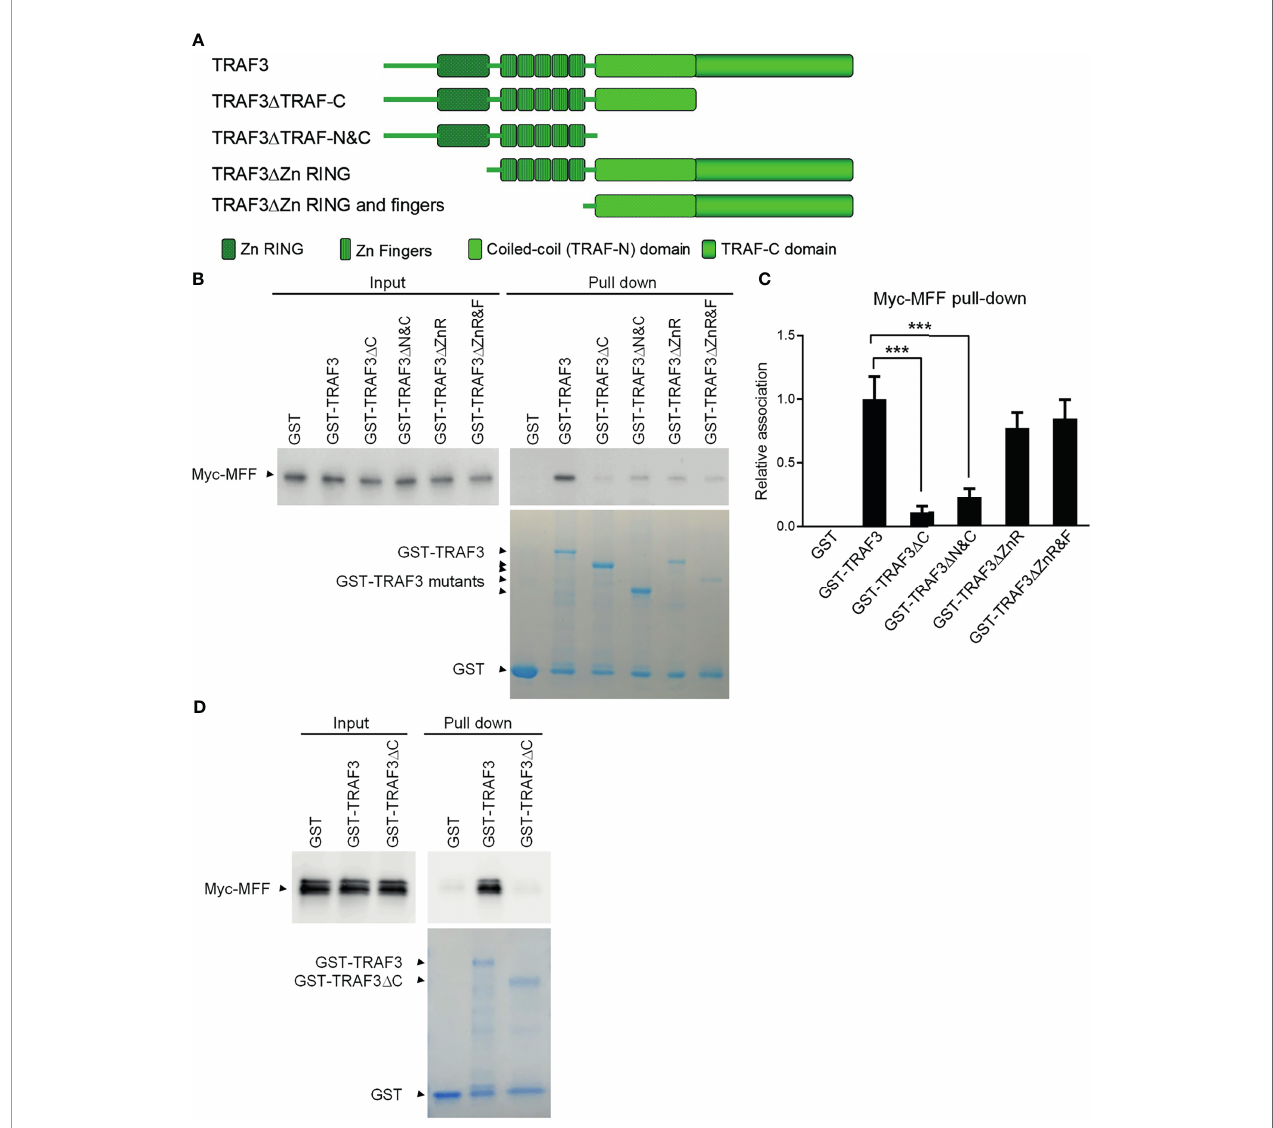
FIGURE 3 | Mapping of the structural domains of TRAF3 required for the interaction with MFF. (A) Schematic diagram of the TRAF3 deletion mutants generated in this study and used for the mapping experiments. Structural domains of TRAF3 that were deleted are depicted in the fi gure. (B) Interaction with MFF determined by the GST pull-down assay. Pre-cleared whole cell lysates of 293T cells transfected with pcDNA3-Myc-MFF were used in the pull-down experiments by GST alone or GST fusion proteins of WT or deletion mutants of TRAF3 in the presence of Glutathione-Sepharose beads. GST, GST-TRAF3 and GST-TRAF3 deletion mutants used for pull-down were analyzed by SDS-PAGE and visualized by GelCode blue staining (the bottom panel). GST-TRAF3 deletion mutants examined include GST-TRAF3 D TRAF-C ( D C), GST-TRAF3 D TRAF-N&C( D N&C), GST-TRAF3 D Zn RING ( D ZnR), and GST-TRAF3 D Zn RING and fi ngers ( D ZnR&F). Lysates that were puri fi ed by the same pull-down procedures with GST alone were used as a negative control and those with GST-TRAF3 were used as the positive control. Myc-tagged MFF in the input lysates and pull-down proteins were detected by immunoblotting (the top panel). Results shown are representative of 3 experiments. (C) Graphical results of the relative association between Myc-MFF and GST fusion proteins of WT or deletion mutants of TRAF3. The Myc-MFF bands on the immunoblots and GST-TRAF3 or mutant bands on the GelCode Blue stained gels in (B) were quantitated using a low-light imaging system and the ImageJ Software, respectively. The amount of Myc-MFF in each pull-down lane was fi rst normalized to the intensity of the corresponding input Myc-MFF band and further normalized to the intensity of the corresponding GST-TRAF3 or mutant band. Fold of change of the normalized Myc-MFF pull-down relative to that detected for GST-TRAF3 WT was shown in the graph (mean ± SD, n = 3). *** p < 0.001 by one-way ANOVA. (D) Direct interaction between TRAF3 and MFF determined by GST pull-down assay of in vitro translated proteins. Pre-cleared protein lysates of in vitro translated Myc-MFF were used in the pull-down experiments by GST alone, GST-TRAF3 or GST-TRAF3 D C in the presence of Glutathione-Sepharose beads. Myc-tagged MFF in the input lysates and pull-down proteins were detected by immunoblotting (the top panel). GelCode blue staining of GST, GST-TRAF3 and GST-TRAF3 D C used for pull-down was shown in the bottom panel. Results shown are representative of 3